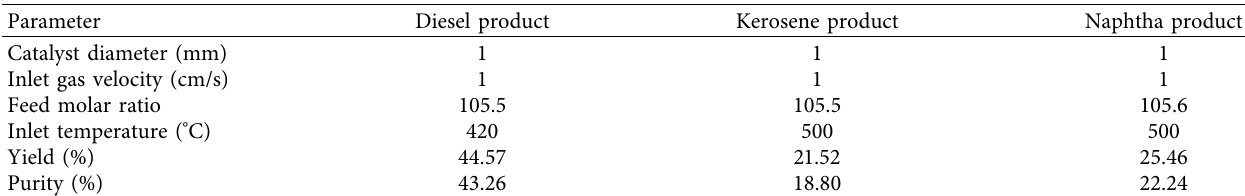
Table 7: Optimisation results based on the purity of each